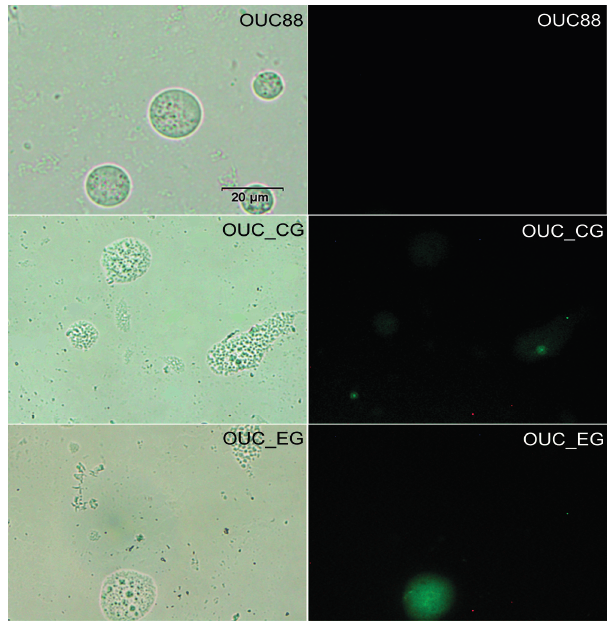
Figure 6. Fluorescence microscopic analysis of the A. limacinum transformant (bars = 20 μ